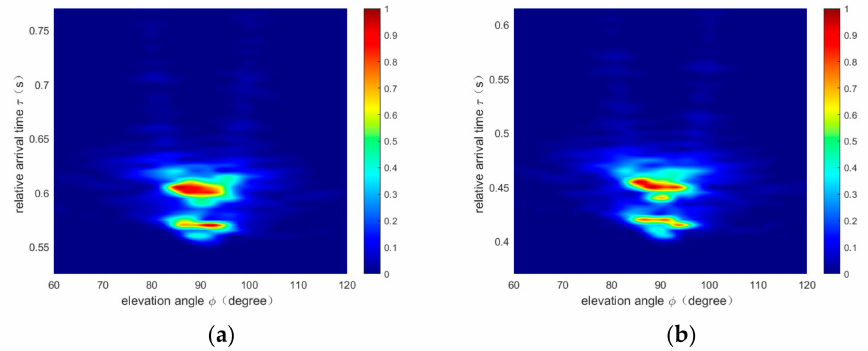
Figure 4. Simulated sound-intensity maps at ( a ) 18 km and ( b ) 20